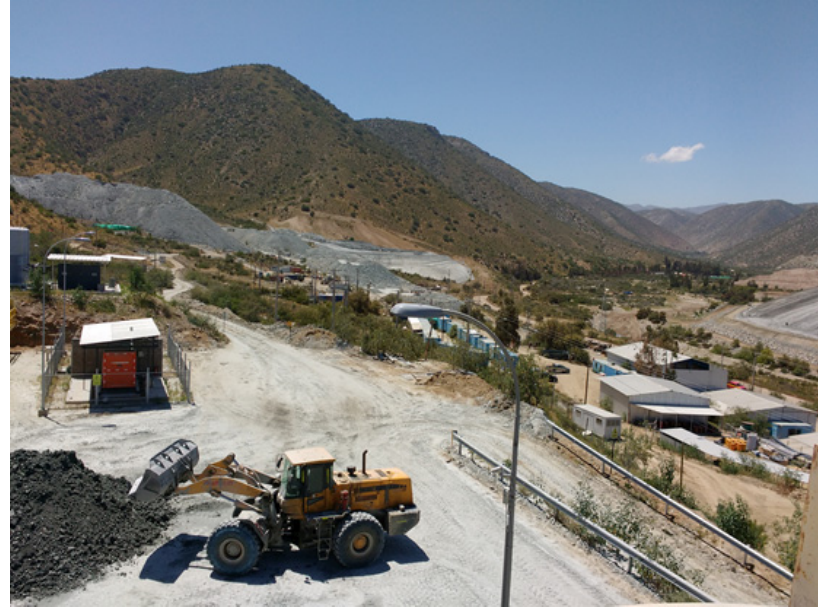
Figure 41. Tambo de Oro Filtered Tailings Storage Facility Overview and Front Loader Works [49].